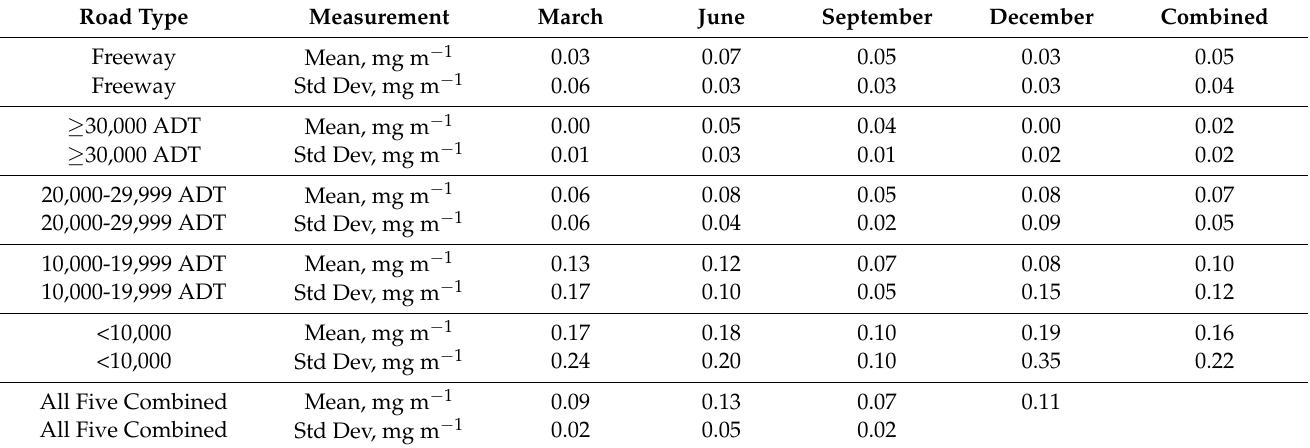
Table 3. Summary of PM 10 emission rates by season, all four seasons, and all five road types combined. Road Type Measurement